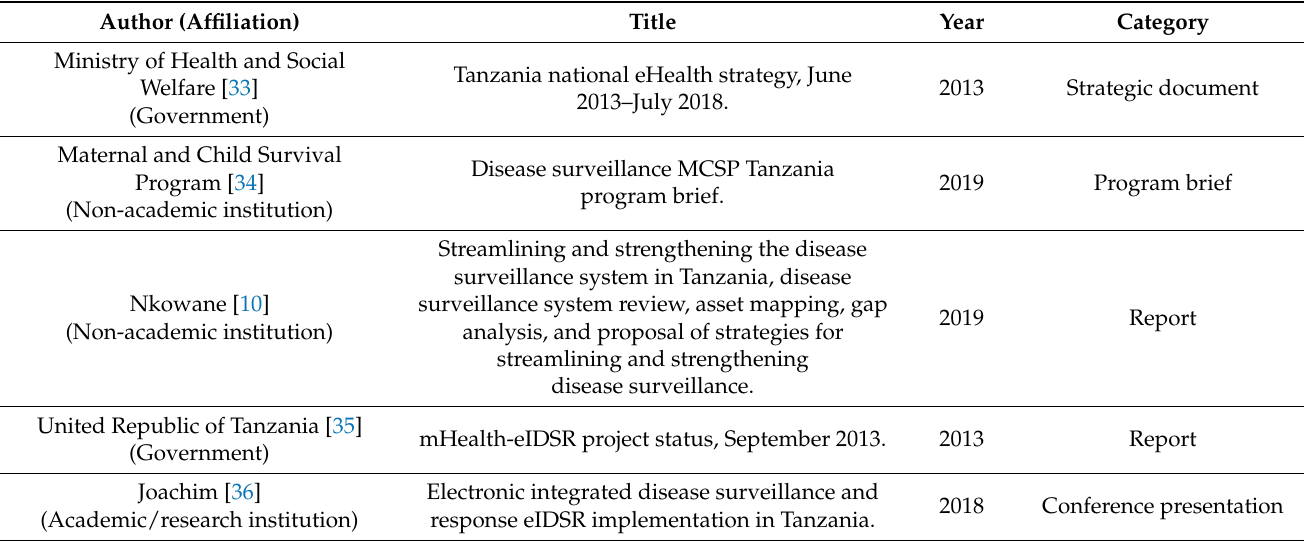
Table 2. Summary of included publications.